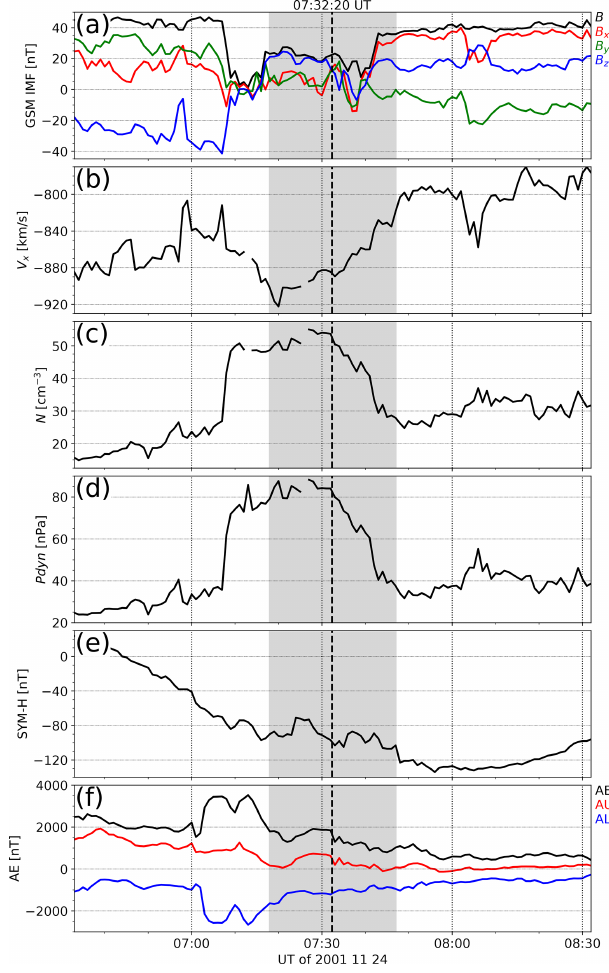
Figure 6. (a) Interplanetary magnetic field (IMF) magnitude and GSM (geocentric solar magnetospheric) components ± 1h around the event on 24 November 2001 at 07:32:20UT. (b) GSM x com- ponent of the solar wind velocity. (c) Solar wind density. (d) Solar wind dynamic pressure. (e) SYM-H index. (f) Auroral electrojet in- dices. The time interval of Fig. 7 (30min) is shaded in grey, and the time of the extreme | d H / d t | event at IMAGE is indicated by the vertical dashed black